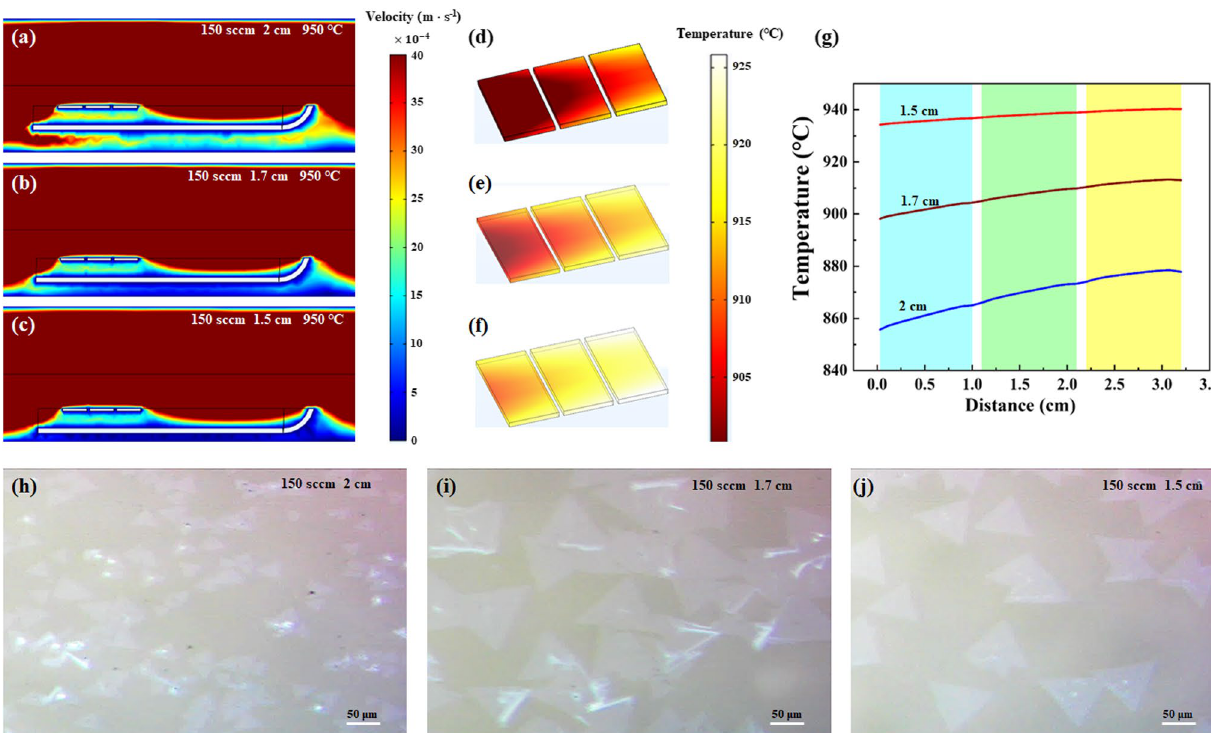
Fig. 3 The COMSOL simulation of a – c gas and d – f temperature distribution for substrate with height of 1.5, 1.7 and 2.0 cm, respectively, away from the bottom of tube, with fixed gas velocity of 150 sccm and temperature of 950 °C. g The extracted temperature curves along the middle line of the three sapphire substrates. h – j The corresponding optical images of WS